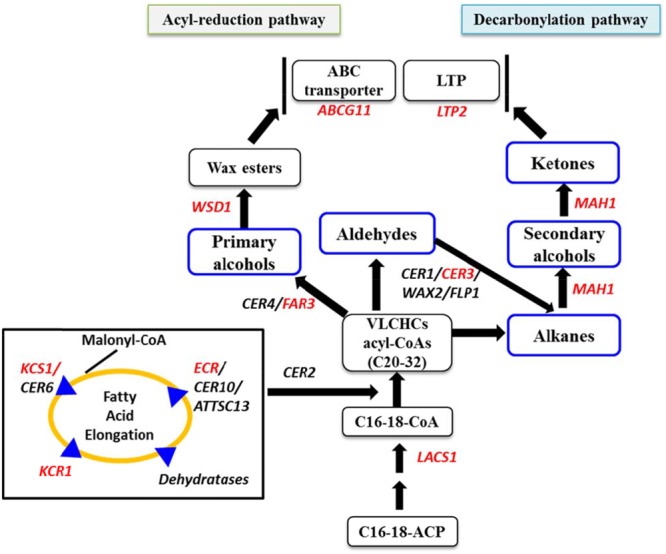
Simplified cuticular wax biosynthetic pathway adapted from Kunst and Samuels (2009), Yeats and Rose (2013), and Lee et al. (2015). Red letters indicate the genes studied by qPCR for relative expression level. Blue boxes indicate biochemical composition of cuticular waxes. LACS1, long chain acyl-CoA synthase 1; KCS1, 3-ketoacyl-CoA synthase; ECR, enoyl-CoA reductase; CER3, protein ECERIFERUM 3; MAH1, midchain alkane hydroxylase 1; CER4 encodes an alcohol-forming fatty acyl-coenzyme A reductase (FAR); LTP2, lipid transfer proteins; FAR3, fatty acyl-CoA reductase; WSD1, wax ester synthase/acyl-coenzyme A: diacylglycerol acyltransferase; ABCG11, ATP-binding cassette (ABC) transporter; C16-18-ACP, C16-C18-Acyl carrier protein; C16-18-CoA, C16-18-Coenzyme-A. LACS1 participates in converting free fatty acids into CoA thioesters.